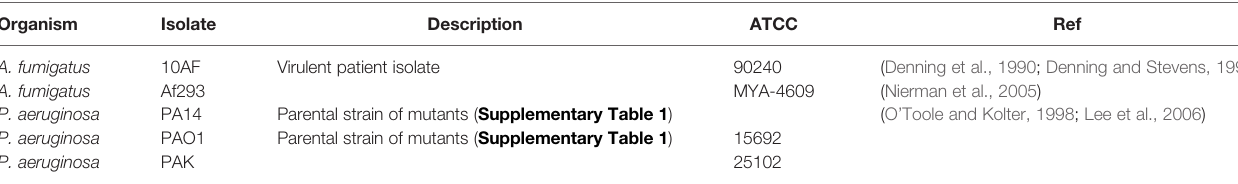
TABLE 1 | Wild-type isolates used in this